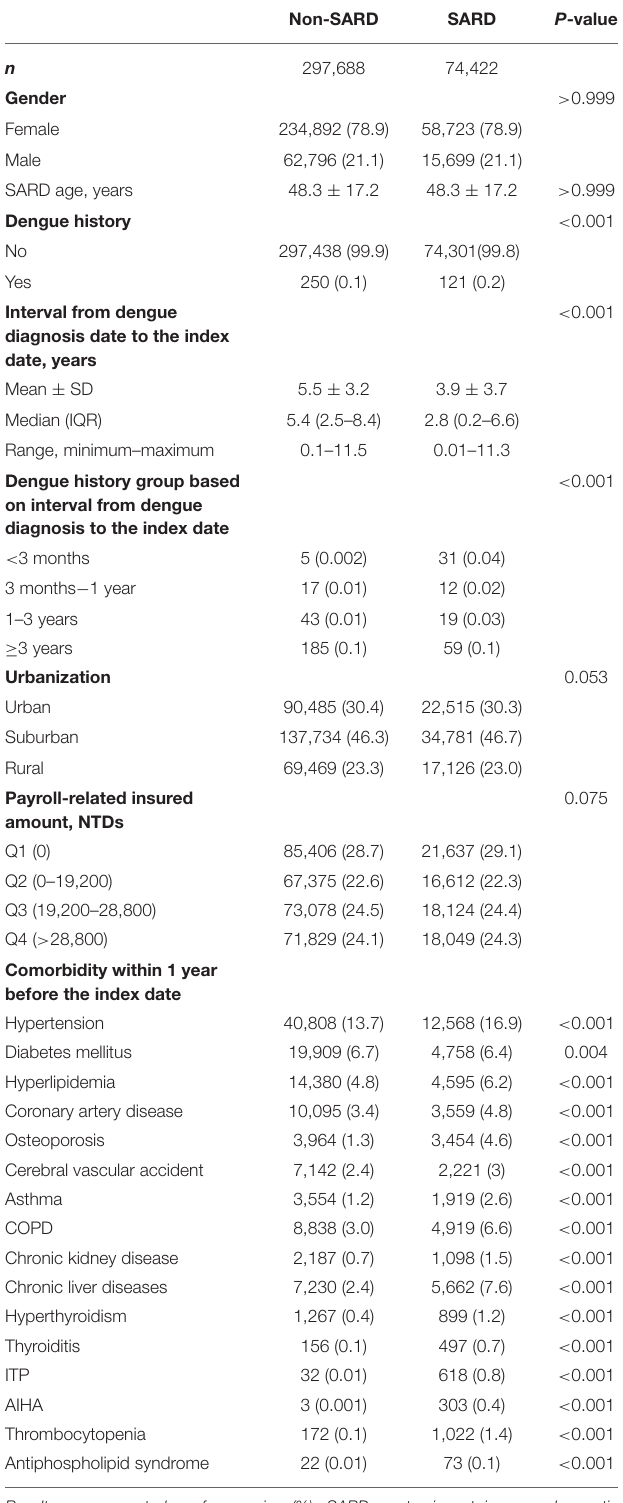
was compatible with the epidemics of reported dengue fever in TABLE 1 | Demographic and clinical data of patients with SARDs and controls. Taiwan Non-SARD SARD